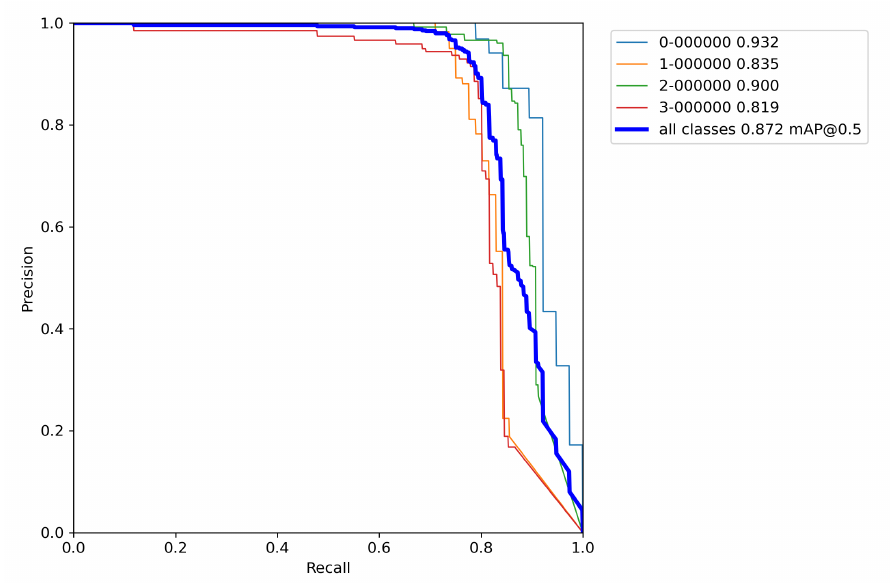
Figure A12. Model trained with augmentation pipeline P–R curve—Experiment 2.